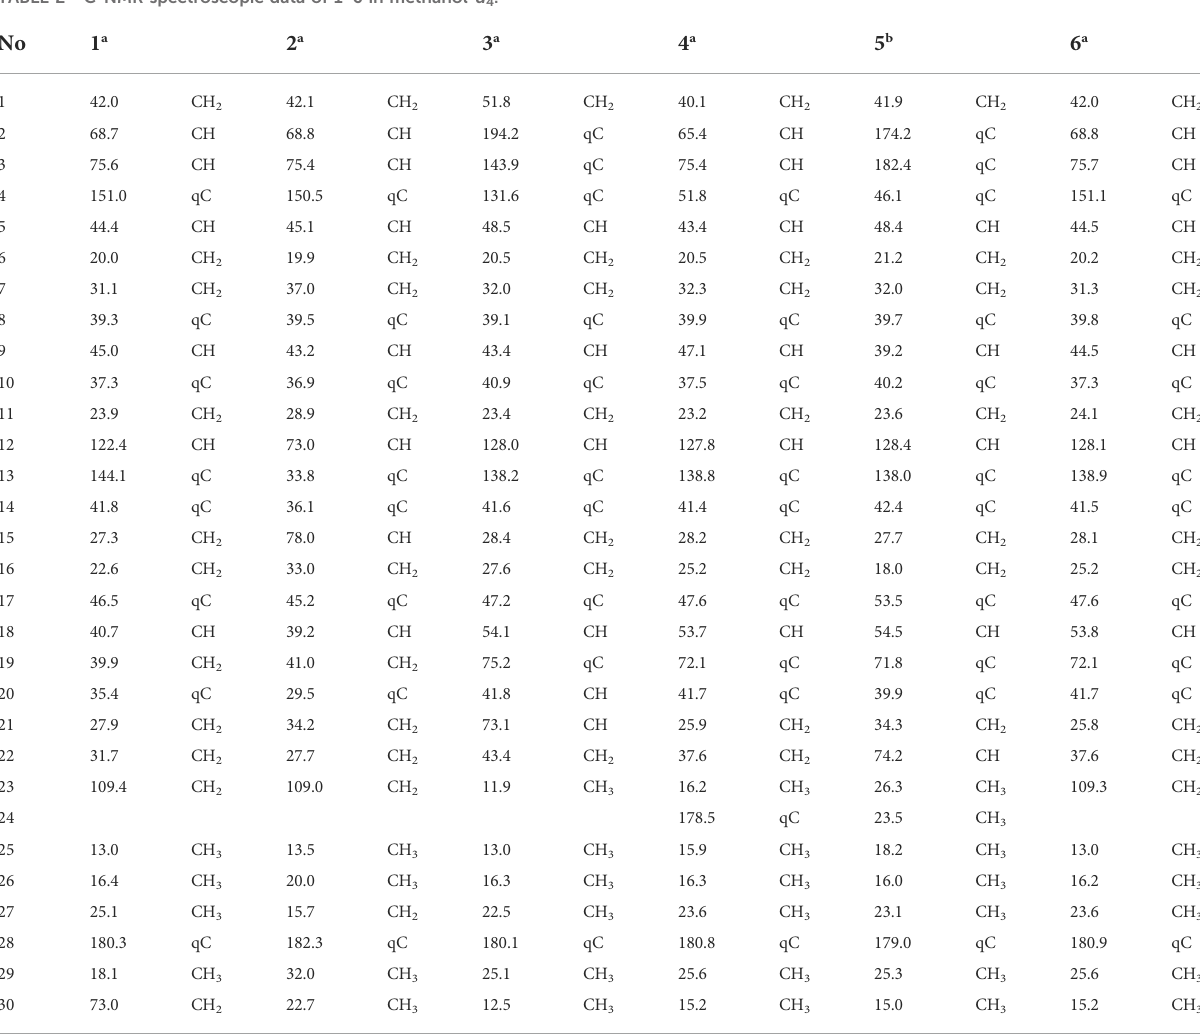
TABLE 2 13 C-NMR spectroscopic data of 1 ‒ 6 in methanol- d 4